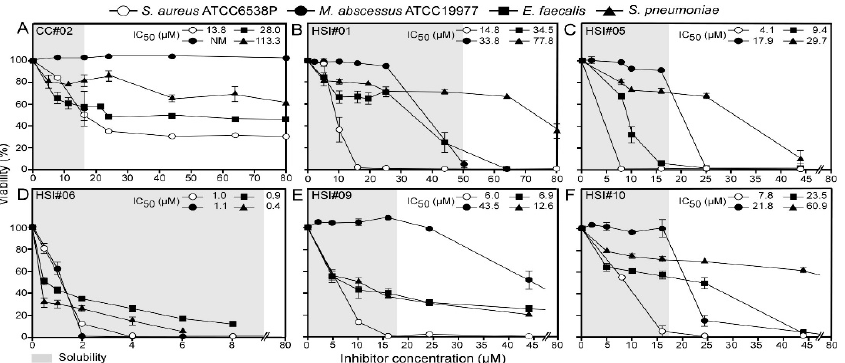
Figure 3. Antibacterial activity of the secretion inhibitors toward Gram-positive bacteria. ( A )–( F ). Inhibition of bacterial viability by the indicated inhibitors and CC#02. Growth of the indicated Gram-positive strains was plotted against the inhibitor concentration (as in Figure 2b). IC 50 values are indicated. n = 3 . The results are presented as the mean ± SD. Gray shade: aqueous solubility.